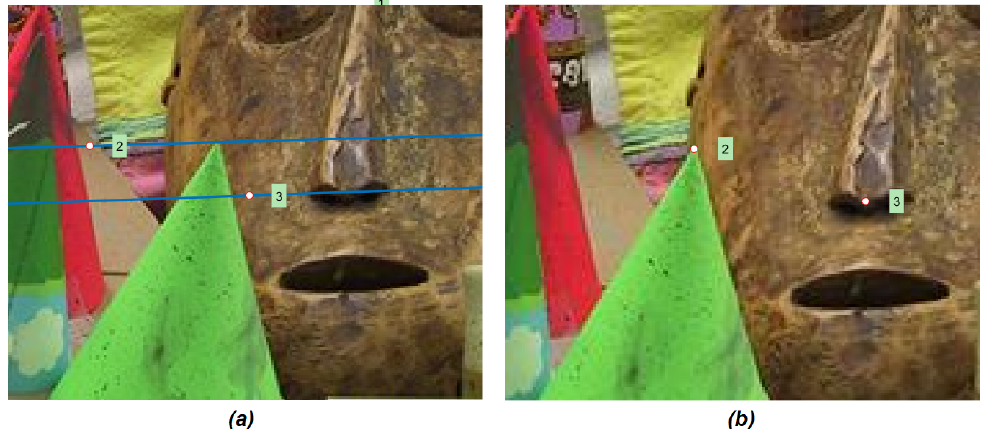
Figure 4. Details of the images shown in Figure 3. The tip of the cone (i.e., point number 2 in the image ( b ) depicting the right view I R ) corresponds to a point that lies on the corresponding epipolar line (i.e., line number 2 in ( a )) on the left view I L